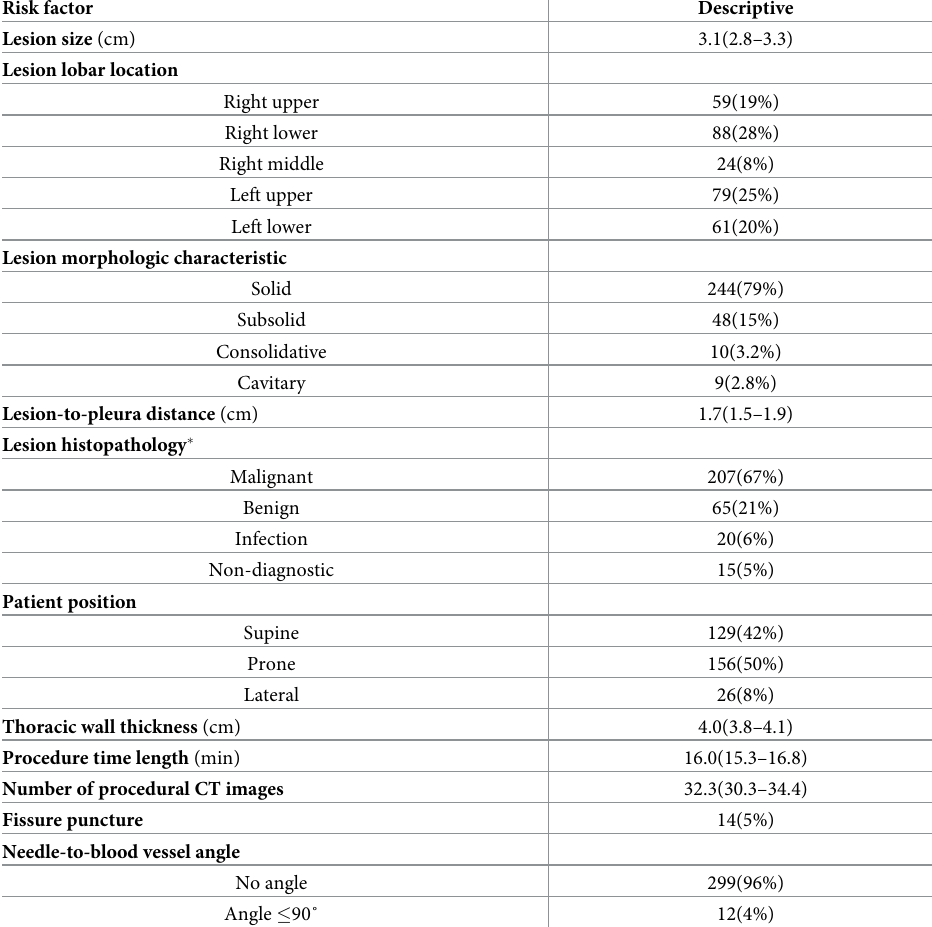
Table 1. Lesion- and procedure- variables as risk factors for complications of CT-guided lung biopsy (n = 311). Risk